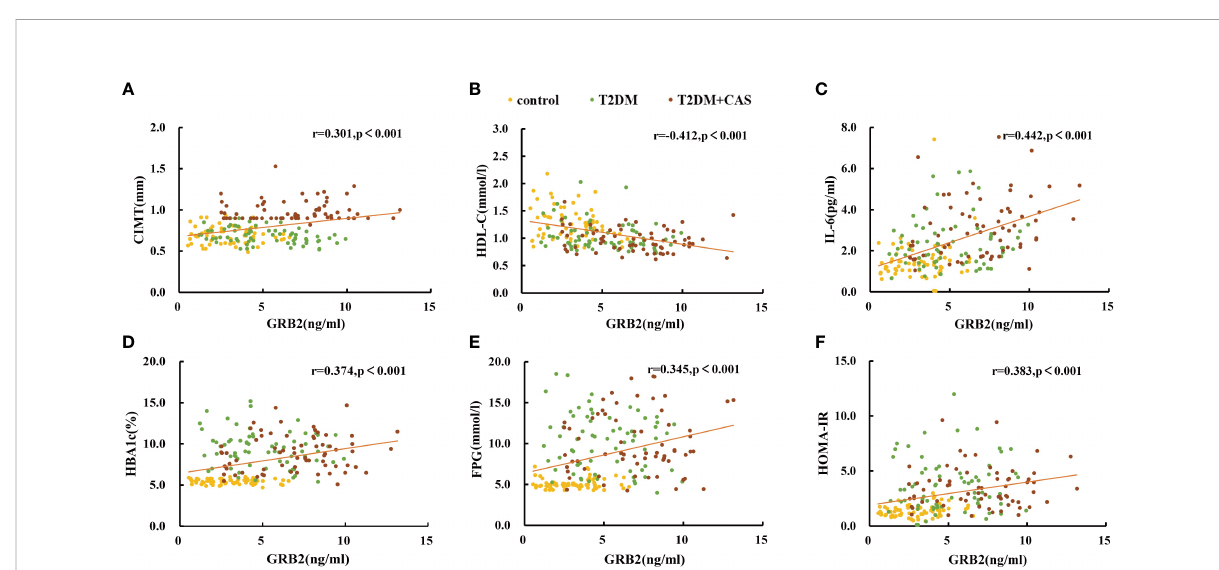
FIGURE 2 Scatter plots showing the correlation between serum GRB2 concentrations and (A) CIMT, (B) HDL-C, (C) IL-6, (D) HBA1c, (E) FPG, and (F) HOMA-IR in